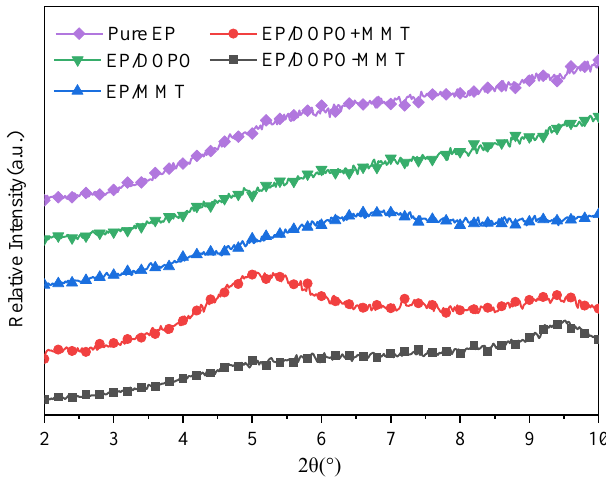
Figure 2. XRD pattern of EPs.